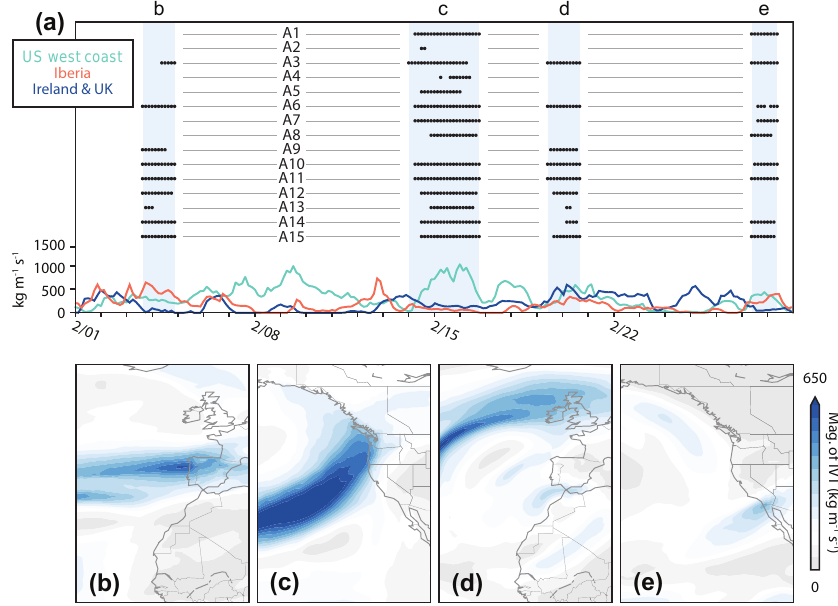
Figure 7. (a) Time series of daily IVT anomalies for (orange) Iberia, (teal) the US west coast, and (blue) Ireland and the UK. Four events of varying geometry and intensity are shaded in panel (a) and composites for each event are shown in panels (b) – (e) . The black dots above the time series in panel (a) indicate time slices in which each event is detected by an algorithm.